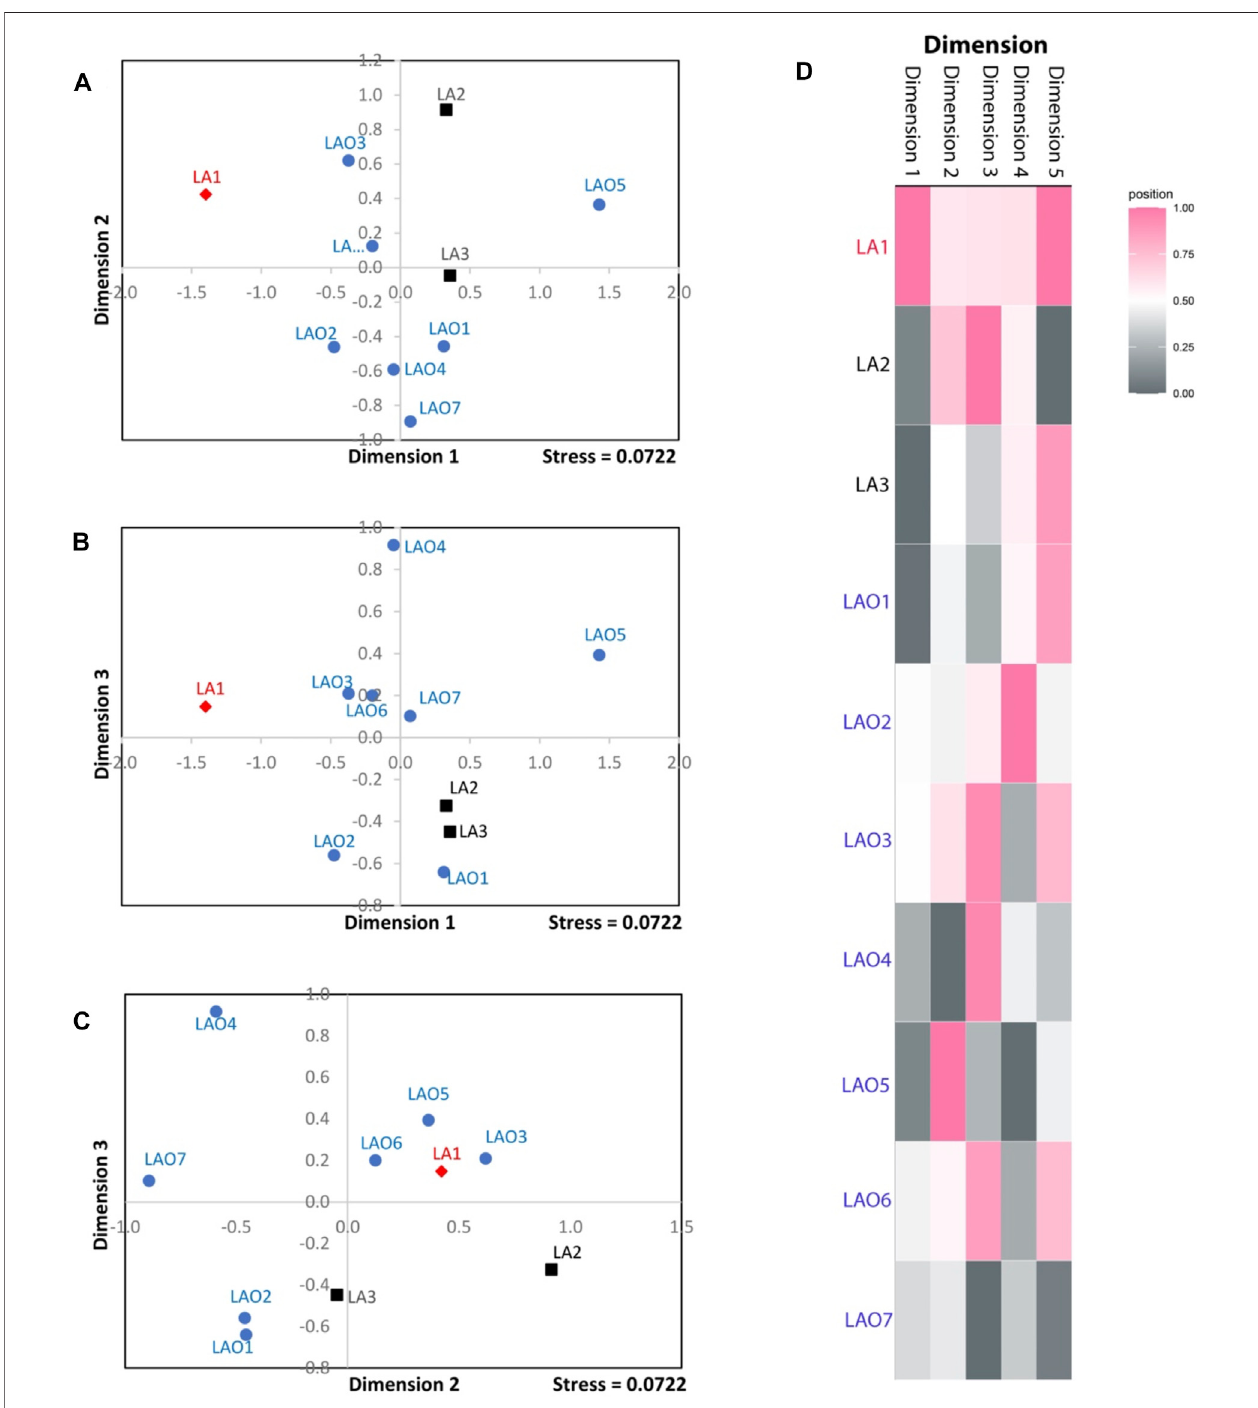
FIGURE3| Thethree-dimensionalMDSplotofdimension1vs.2 (A) ,1vs.3 (B) and2vs.3 (C) oftotal10populations.TheheatplotofstandardizedvaluesofMDS with fi ve dimensions (D) . Red diamond, black squares, and blue circles represent AA-speaking Laotian, TK-speaking Laotians and Lao Isan populations, respectively.